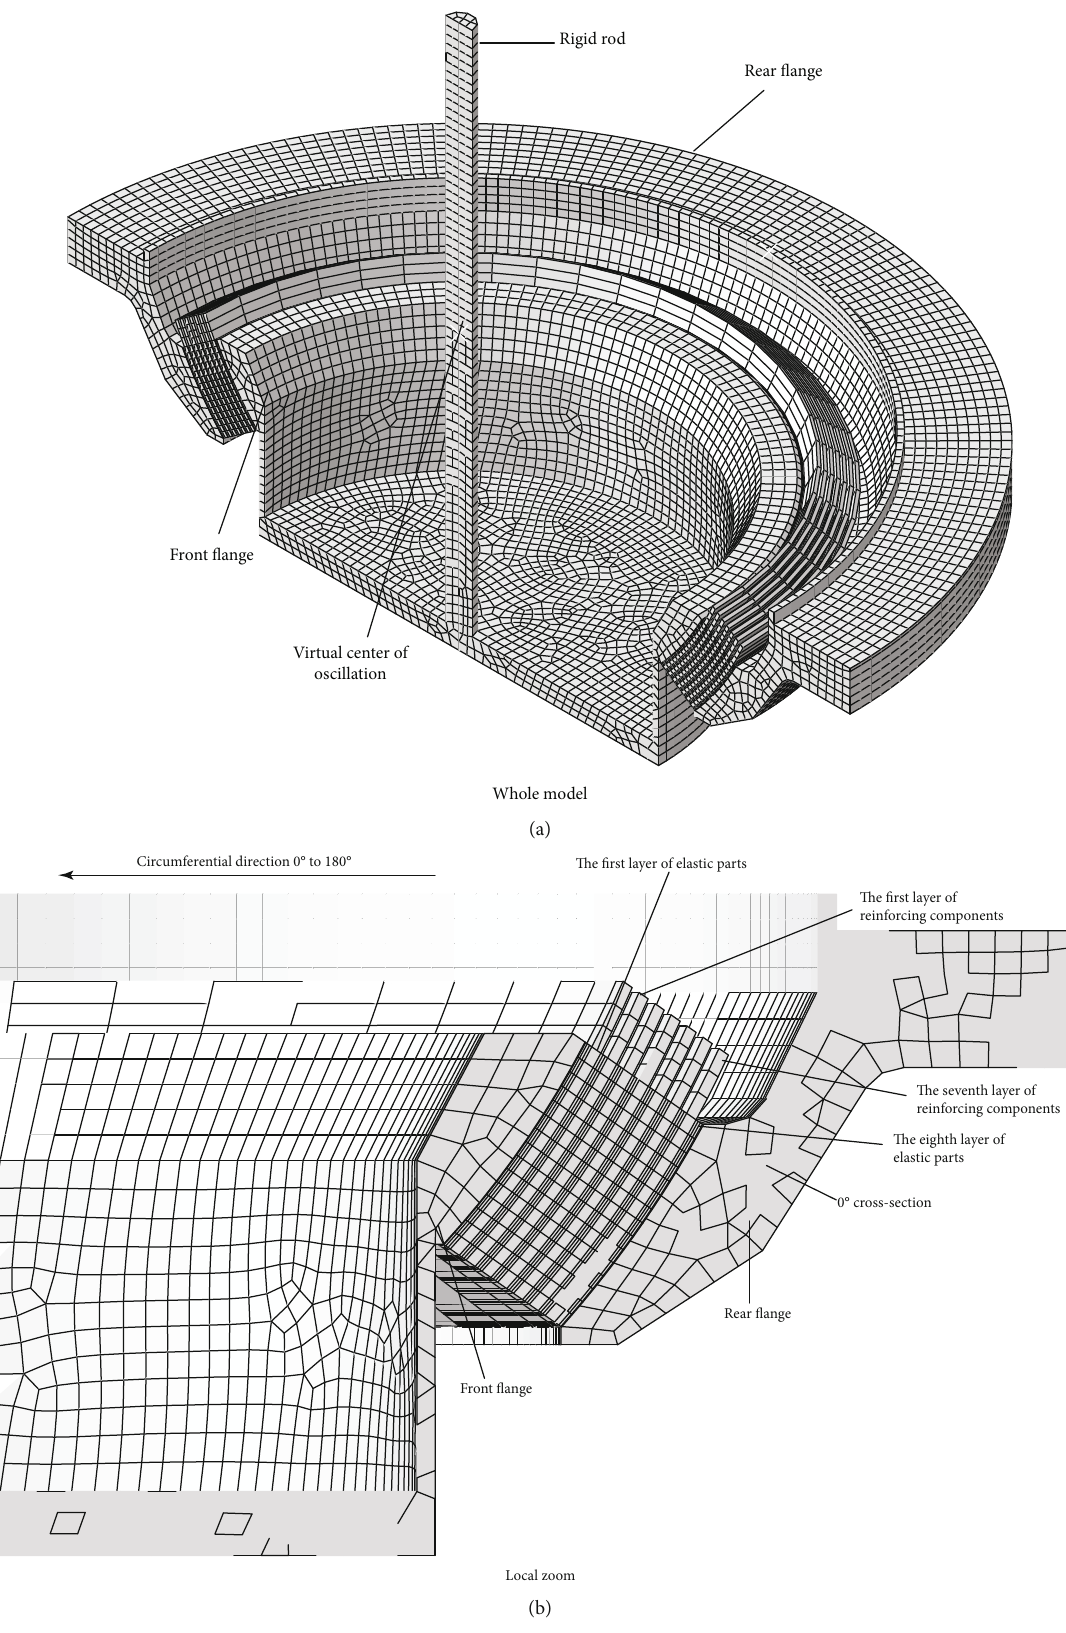
Figure 5: Flexible joint computing